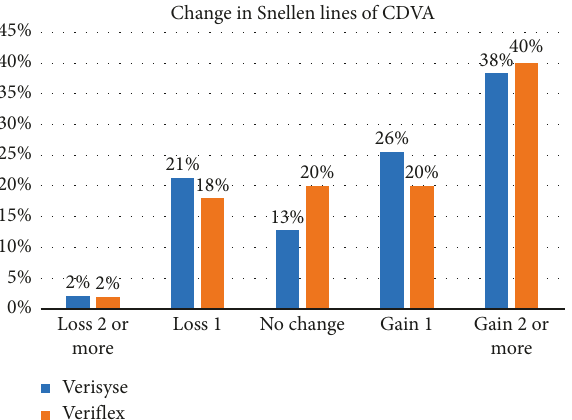
Figure 3: Change in corrected distance visual acuity